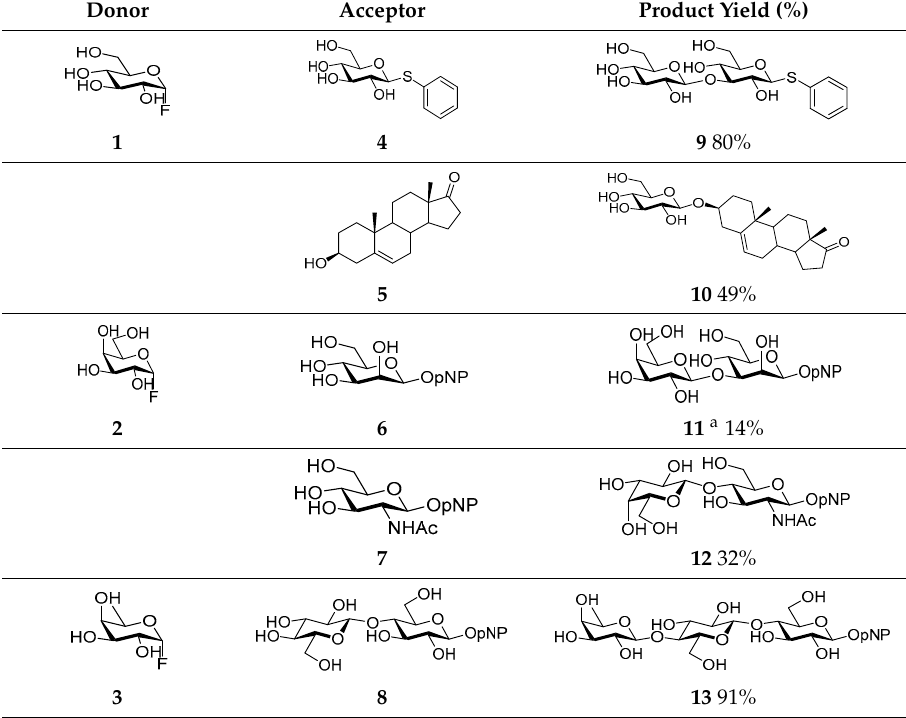
Table 1. Examples of synthetic glycosylation products catalyzed by the TnG E338A [22]. Reactions were carried out with α - D -GlcF ( 1 ), α - D -GalF ( 2 ), or α - D -FucF ( 3 ) as the donor. Donor and acceptor molecules were employed in equal amounts unless otherwise noted. Yields were determined after purification or isolation.